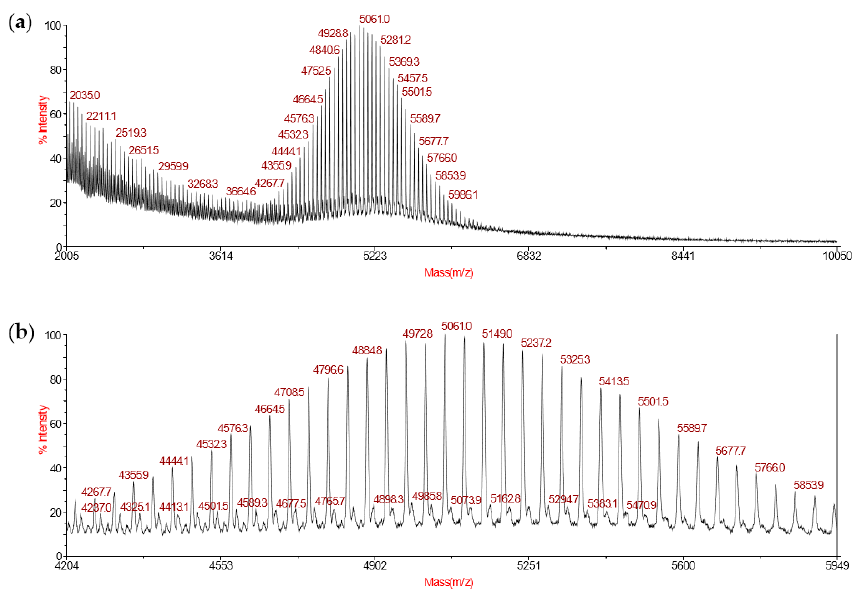
Figure 4. ( a ) Full MALDI-TOF mass spectrum from mass/charge (m/z) 2000 to 10,050 of P1 . ( b ) Magnification of the mass range region from m/z 4204 to 5949. ( b ) Magnification of the mass range region from m / z 4204 to